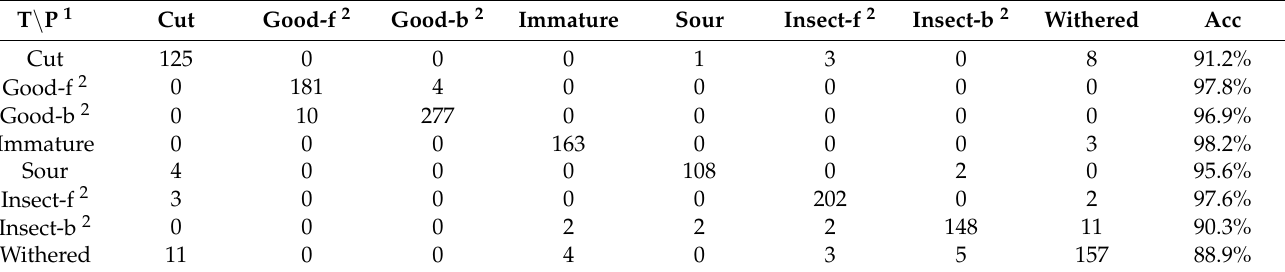
Table 10. Confusion matrix of the network-final model.